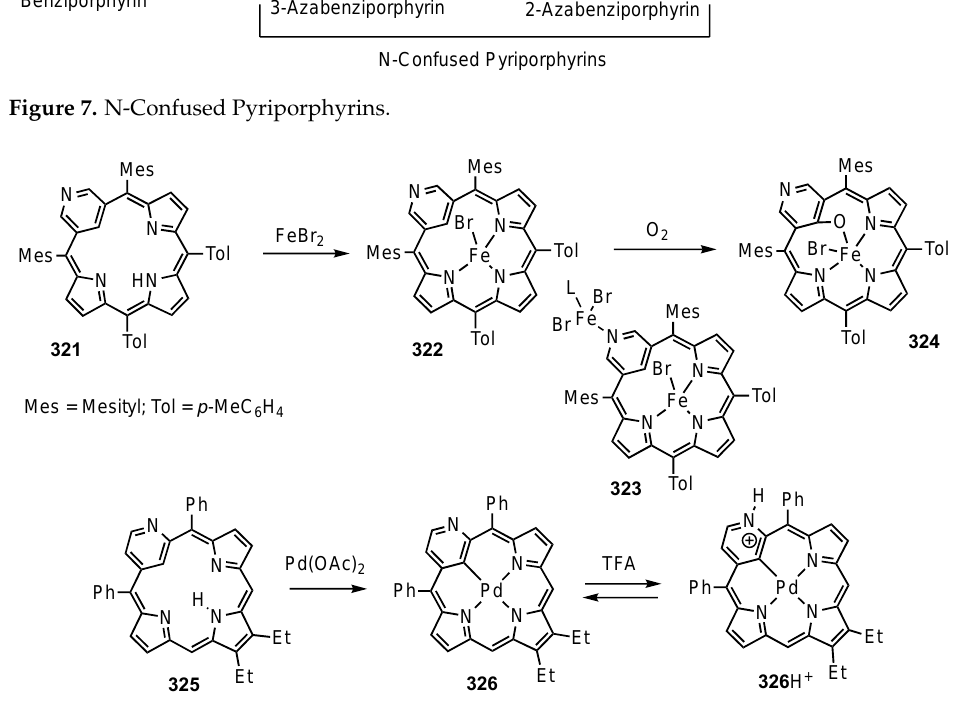
Scheme 52. Metal complexes of N-confused pyriporphyrins.